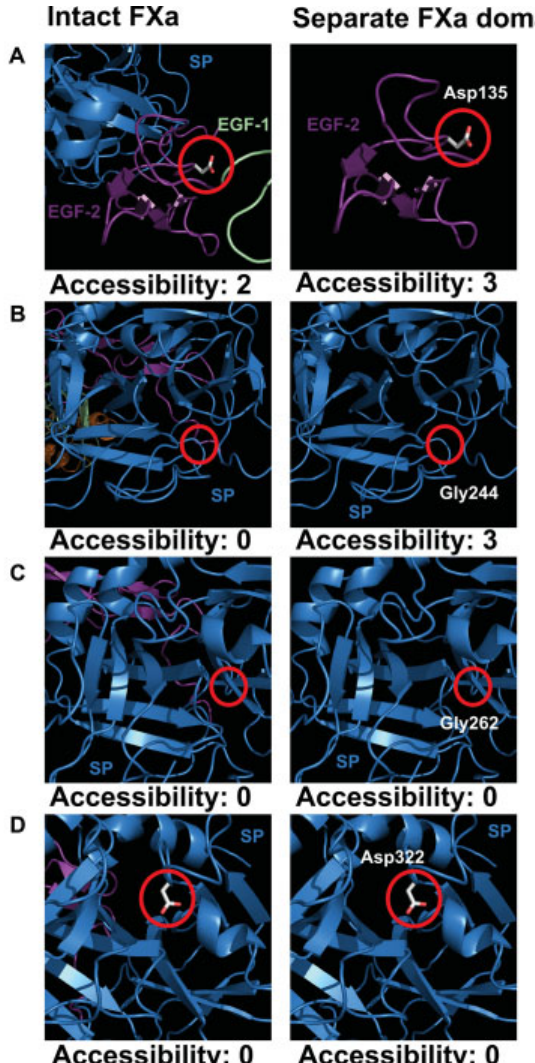
Fig. 9 Molecular graphic representation of four selected variants in the FXa protein structure. The views are taken from the unmodi fi ed FXa structural model (Methods). The left-hand panel highlights the residue of interest and its calculated solvent accessibility in the intact FXa protein. The right-hand side panel shows the same residue in its respective isolated domain, with its corresponding accessibility. ( A – D ) highlight the residues Asp135, Gly244, Gly262 ( ► Fig. 2 ) and Asp322 (catalytic triad) respectively. Accessibility calculations are detailed in the Methods section. The domain coloring corresponds to that in ► Fig. 5 . All residue numbering is given in HGVS